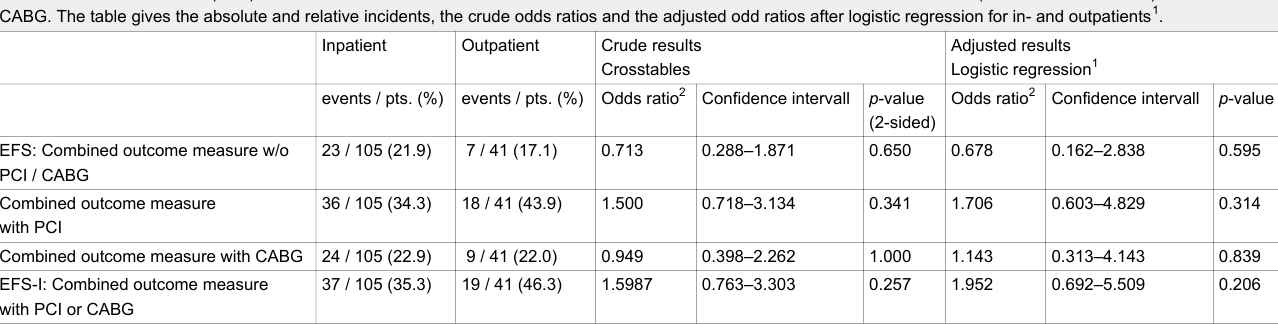
Table 2: Event-free survival (EFS) calculated as combined outcome measure without PCI / CABG, with PCI, with CABG and EFS-I (EFS with interventions) with PCI / CABG. The table gives the absolute and relative incidents, the crude odds ratios and the adjusted odd ratios after logistic regression for in- and outpatients 1 .